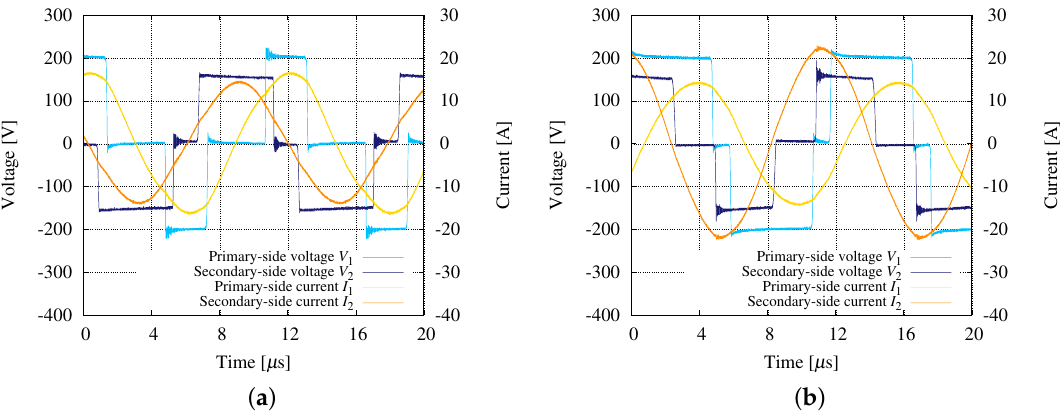
Figure 10. Waveforms of voltages and currents in the resonant circuit at E 1 = 200 V, E 2 = 150 V, and I charging = 8 A.( a ) hard-switching operation; ( b ) soft-switching